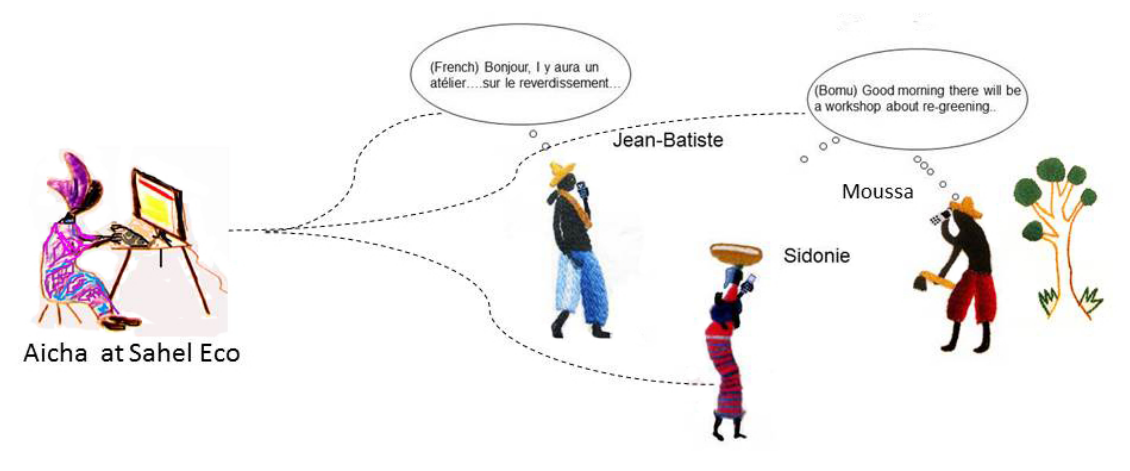
Figure 5. Informal sketch of an envisaged system, showing the scope of the system and its